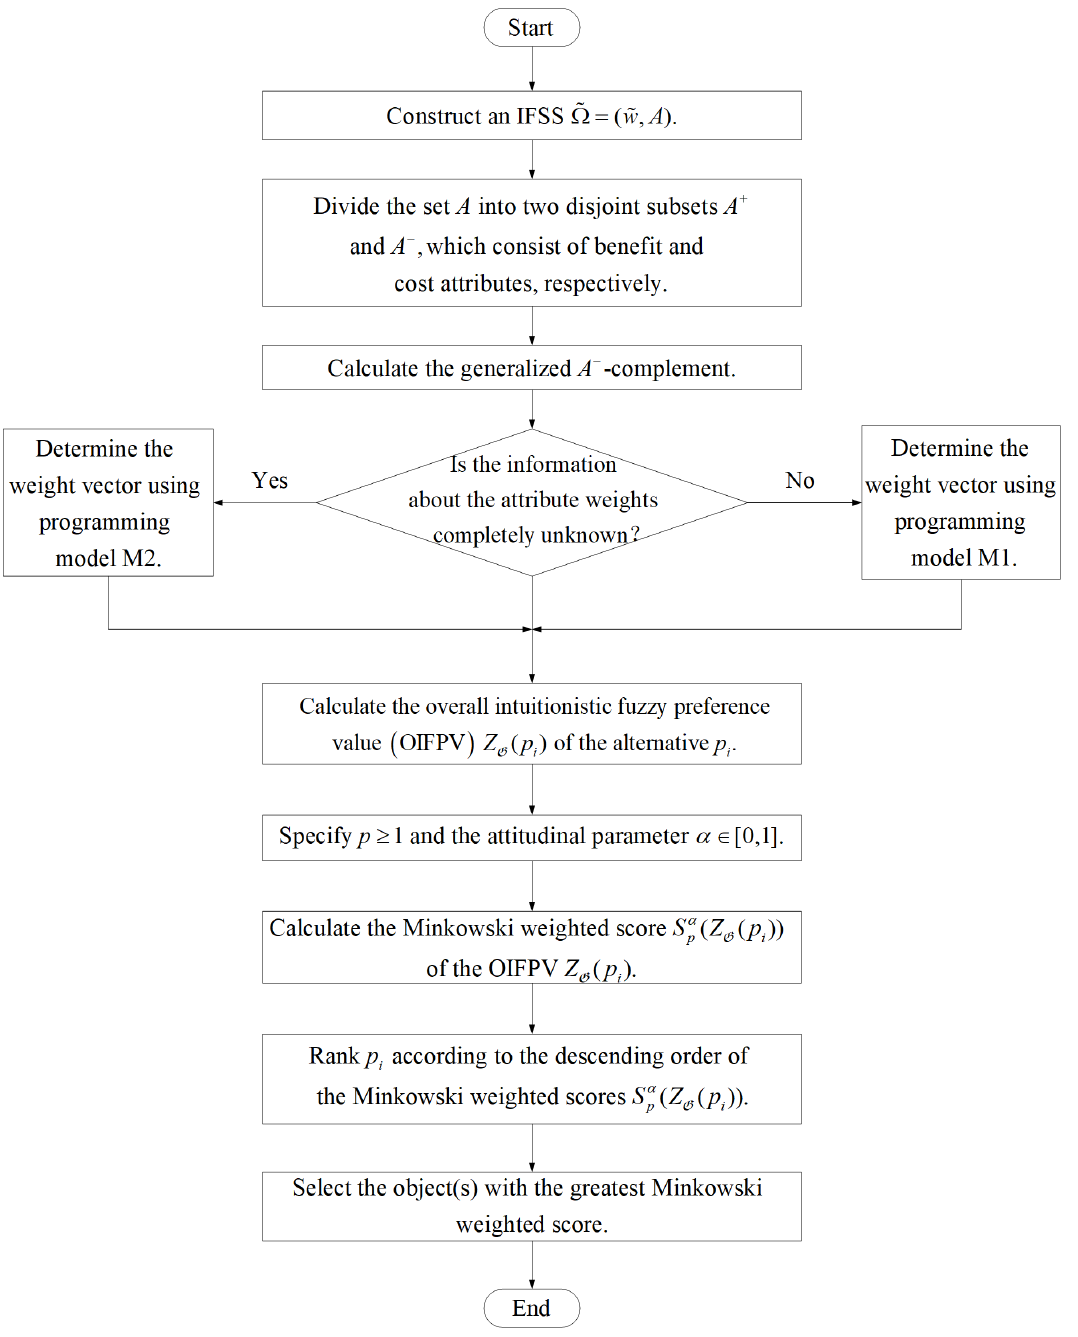
Figure 2. Flowchart of the proposed algorithm for intuitionistic fuzzy